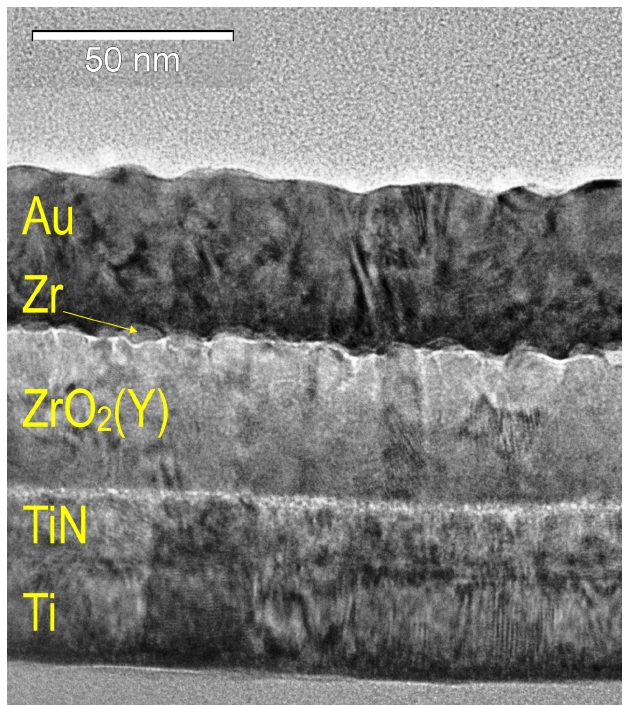
Figure 2. The cross-sectional TEM image of the memristive device structure after electroforming. The thickness of the ZrO 2 (Y) layer was 40 nm, the thickness of the top Au electrode was 40 nm, and the thickness of the bottom TiN/Ti electrode was 40 nm.